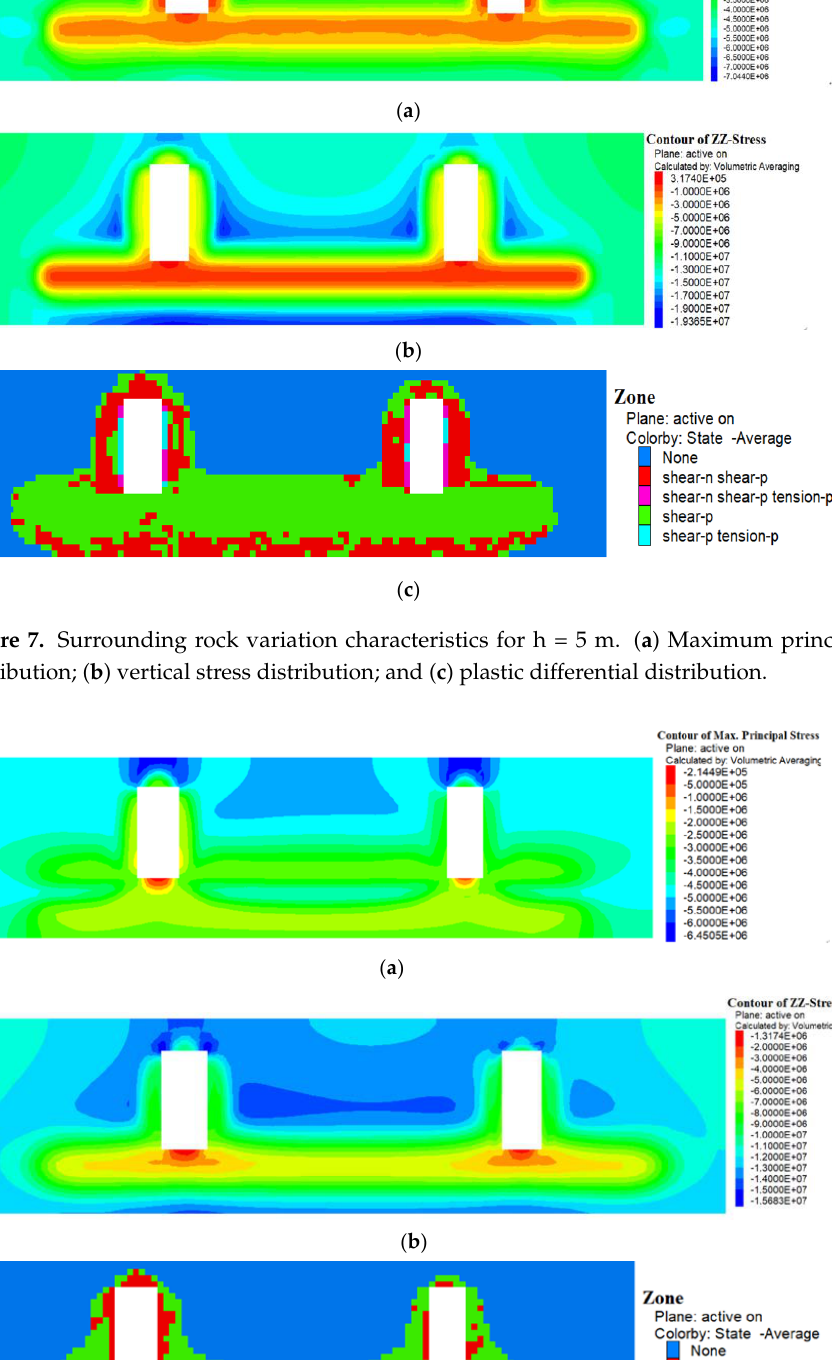
Figure 6. Surrounding rock variation characteristics for h = 3 m. ( a ) Maximum principal stress dis- tribution; ( b ) vertical stress distribution; and ( c ) plastic differential distribution.